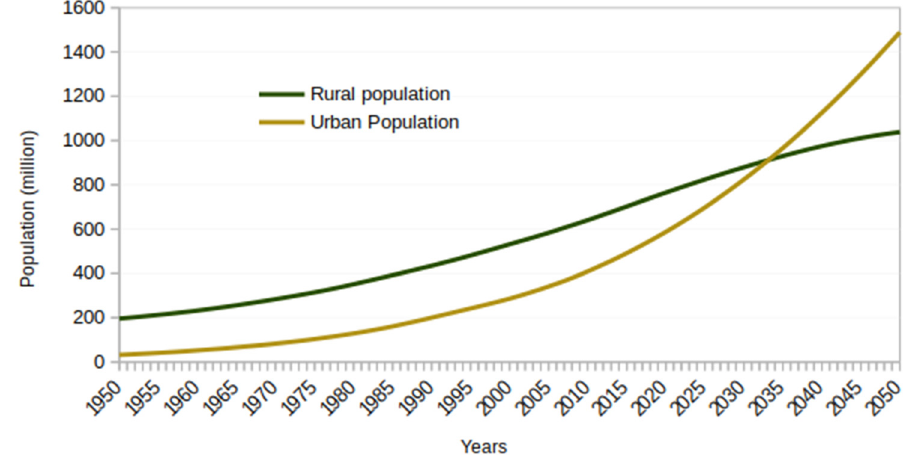
Figure 1. Urban and rural population growth in Africa [5].